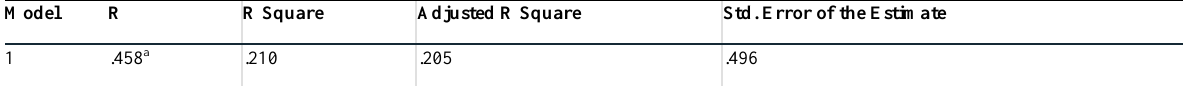
Table 6: Regression Model summary for monitoring and evaluation; and sustainability of DFLPs